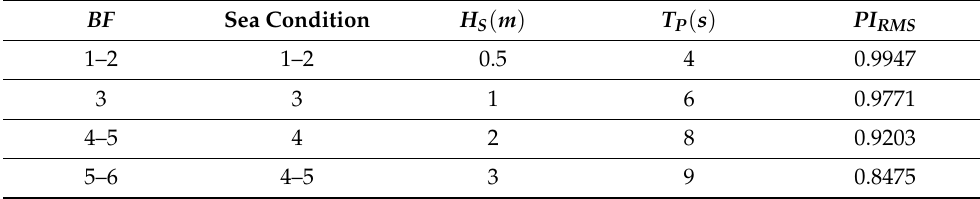
Table 1. Performance indexes for different sea